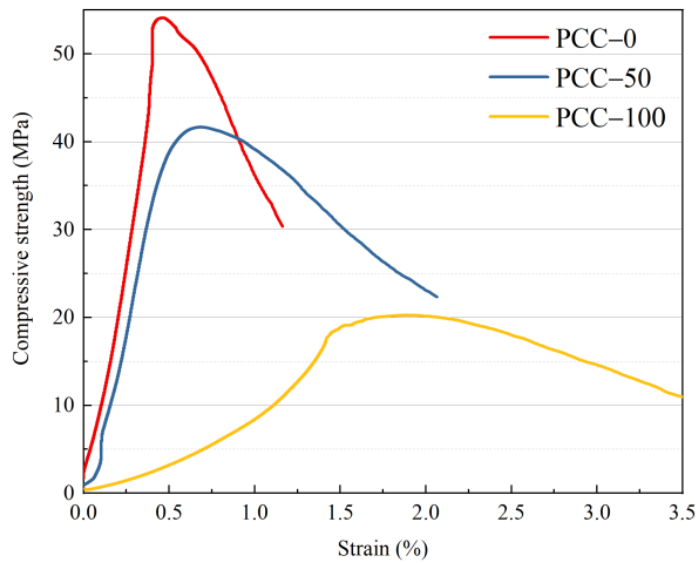
Figure 9. Stress – strain curve of concrete with different substitution amounts of phase change aggre- Figure 9. Stress–strain curve of concrete with different substitution amounts of phase change gates.